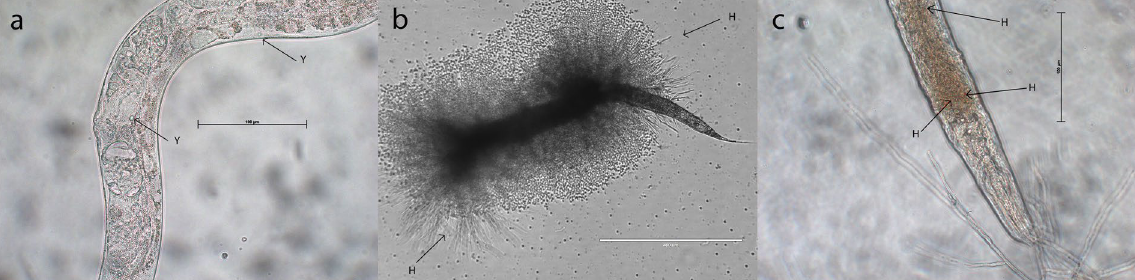
Figure 2. Morphological analysis of E. dermatitidis in C. elegans after infection and incubation of infected nematodes for 72 h. Three separate pictures of E. dermatitidis development in C. elegans could be observed, leading to death: ( a ) Adherence of mainly fungal budding cell on the intestinal wall; proliferation and obstipation continued until no free intestinal structure could be observed, leading to death. ( b , c ) Invasive hyphal structures from inside the intestine to outside, leading to death. Scale = 400 µ m.